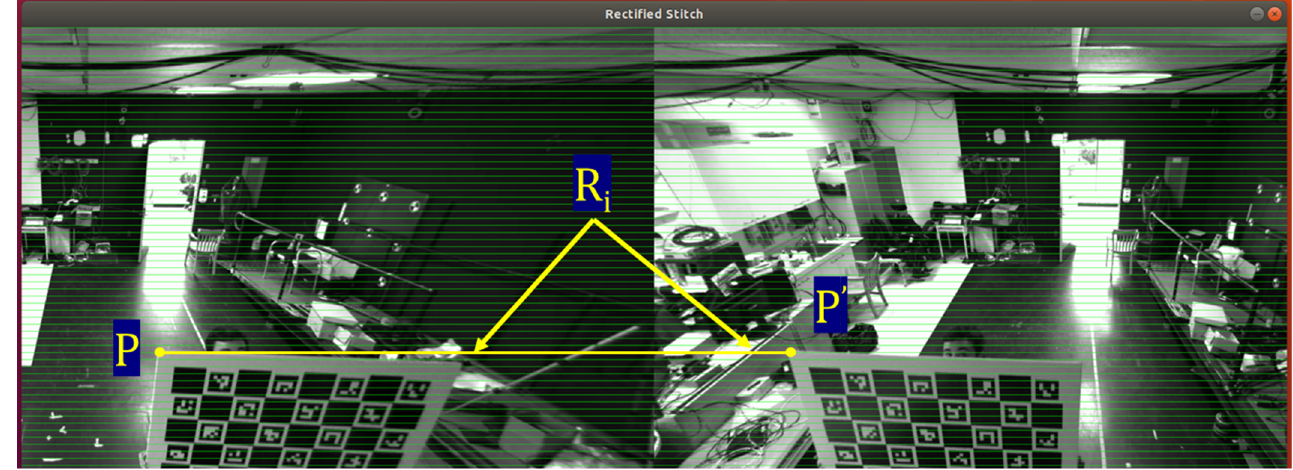
Figure A9. Finding a point, P, in the left image and point, P ′ , in the right image along the same epiline to validate the epipolar constraint.